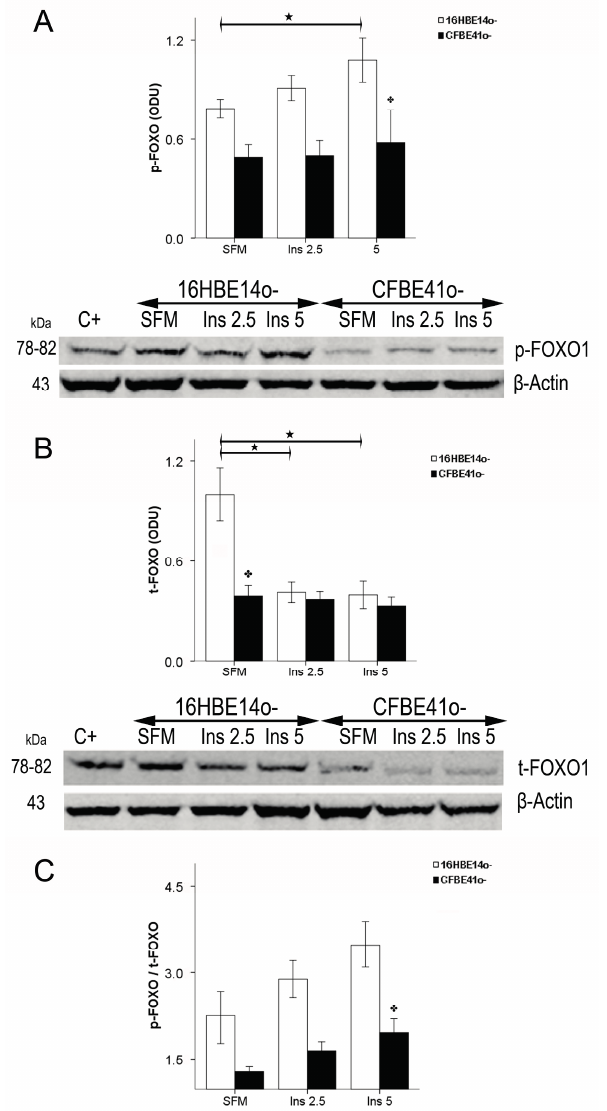
Figure 3. Phosphorylated [S256] FOXO1 (p-FOXO1) contents ( A ), total FOXO1 (t-FOXO1) contents ( B ), and p-FOXO1/t-FOXO1 ratio ( C ) in CF-affected and normal cells. ( A ) p-FOXO1, expressed in ODU was higher in 16HBE14o- cells and increased significantly with insulin stimulation, whereas no change was seen in CFBE41o- cells. Bars represent the mean ± SEM of all experiments in both groups ( n = 6). SFM: serum-free medium. Beneath is a representative immunoblot showing p-FOXO1 in the different conditions in both cell lines. C+: positive control; ( B ) t-FOXO1 was significantly higher in serum-free medium (SFM) in 16HBE14o- with respect to CFBE41o- cells, and decreased significantly after insulin stimulation. In CFBE41o- cells the baseline content was lower and did not change with insulin stimulation. Bars represent the mean ± SEM of all experiments in both groups ( n = 6). Beneath is a representative immunoblot showing p-FOXO1 in the different conditions in both cell lines. C+: positive control; ( C ) p-FOXO1/ t-FOXO1 ratio increased with insulin stimulation in 16HBE14o- cells and was always more elevated than in CF cells. The bars represent the mean ± SEM of all experiments in both groups ( n = 6). p < 0.05 SFM vs . insulin treatment; p < 0.05 CFBE41o- vs .